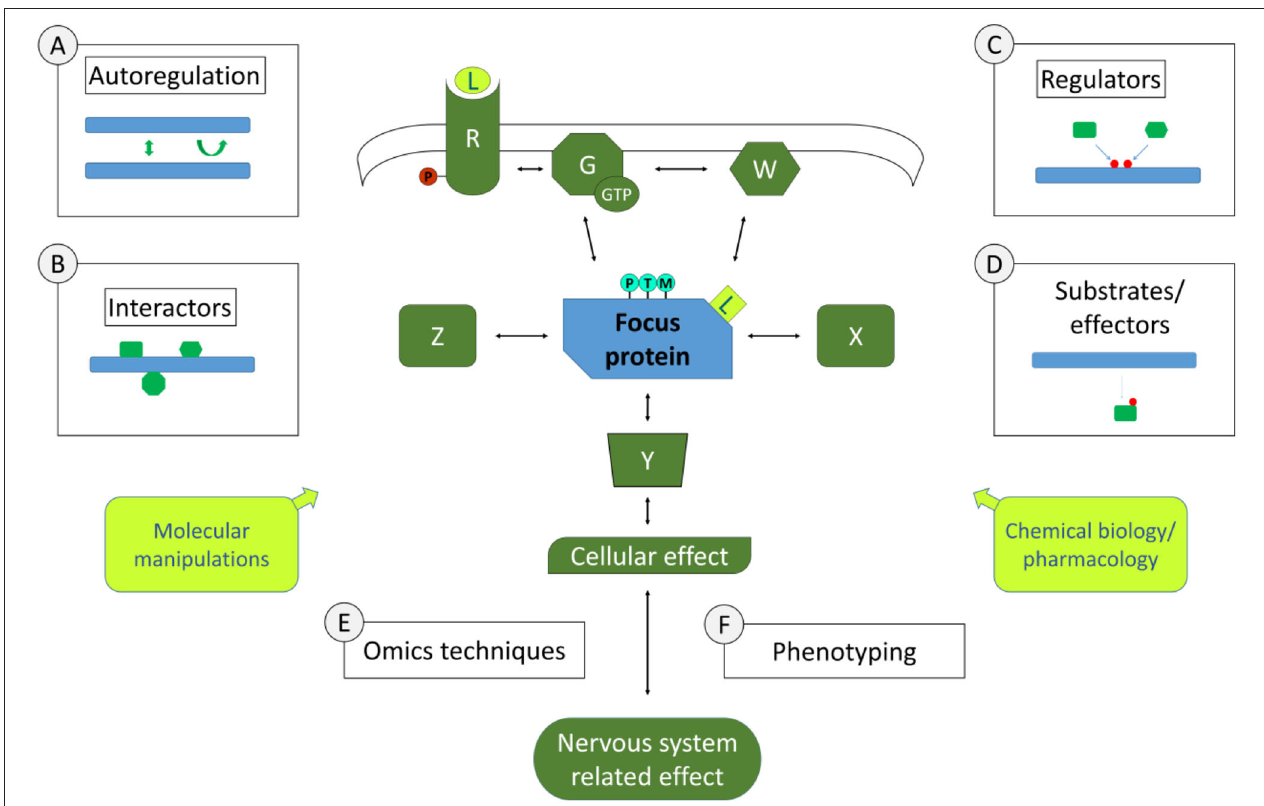
FIGURE 1 | Molecular Signalling and Pathways in Neuroscience. Depicted centrally is a simplified schematic of elements of a signalling pathway involved in nervous system functions. Molecular signalling pathways are of interest in their whole (all elements in green and the one in blue) as well as in the characteristics of individual components (symbolised by the blue focus protein). Study around focus proteins can begin to inform in the pathway involved by the study of its autoregulation (approach A, if applicable), its direct physical interactors (approach B, symbolised by theoretical interactors such as X, Z), its upstream regulators [approach C, with theoretical regulators W, or G (G-proteins) and R (receptors), leading also potentially to post-translational modifications (PTMs)], its downstream substrates (Y). Using Omics approaches (E) such as proteomics, transcriptomics etc. as a way to define the profile of cells or tissues in specific conditions, it is also possible to make deductions on the pathway that yielded the measured Omics profile. Omics profiles are also a potential phenotype (F) in their own right, as are more specific measures of the cells involved in the nervous systems related effects, including how this affects specific cellular functions or organelles and how this impacts cell-cell interactions, neuronal circuits or functions of specific tissues. In Molecular Neuroscience, we also have a myriad of tools/approaches to explore pathways functions (yellow boxes), including molecular manipulations such as knock-out, knock-down, knock-in (including via genome-editing techniques such as CRISPR/CAS), protein-protein interaction modulators as well as chemical biology or pharmacological maniplulations such as synthetic or natural small molecule or peptide ligands (L). The ultimate goal is to gain a full picture of the pathway under study, how it is linked to nervous system functions and the equilibria that exist within the pathways and in relation to other pathways under normal and pathological